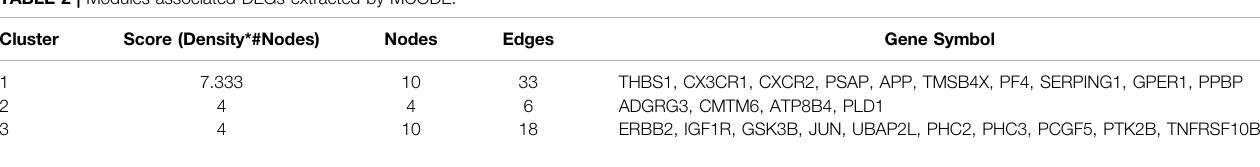
TABLE 2 | Modules associated DEGs extracted by MCODE. Cluster Score (Density*#Nodes) Nodes Edges Gene Symbol